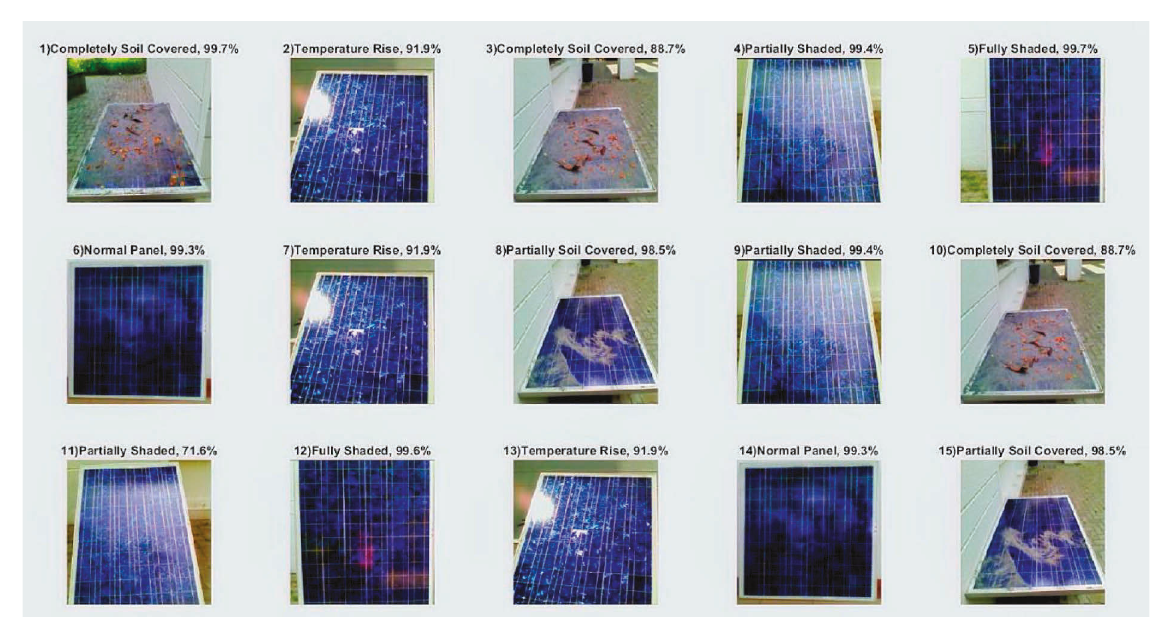
Figure 20: Fault classified by SqueezeNet for real images of solar panels.